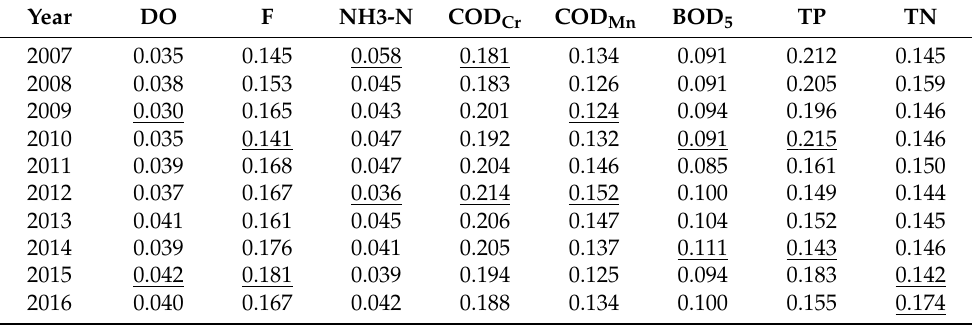
Table 5. ESO weight